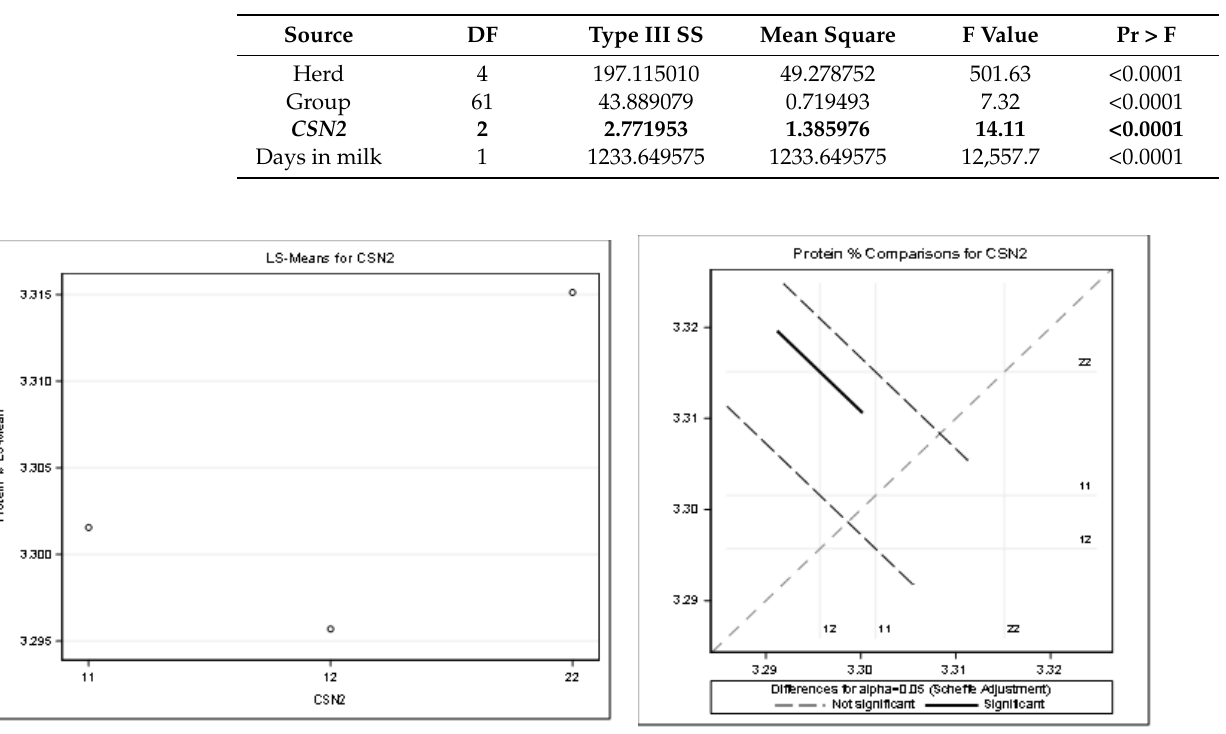
Figure 8. Least squares means and multiple comparisons for protein %.